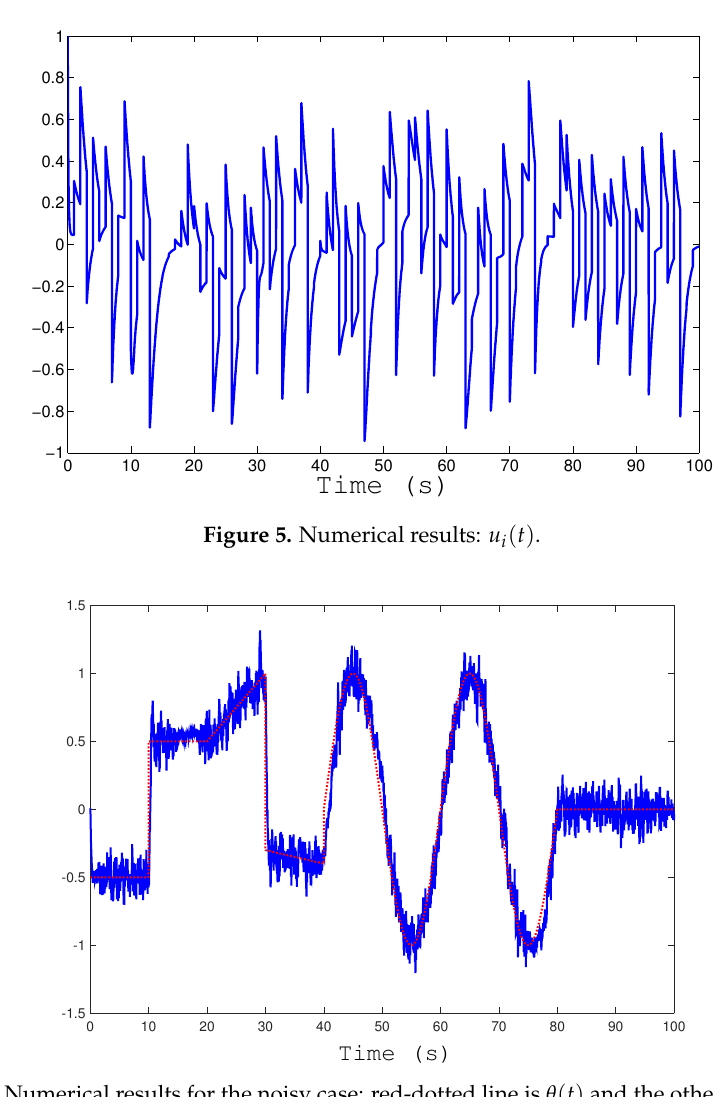
Figure 6. Numerical results for the noisy case: red-dotted line is θ ( t ) and the other one is ˆ θ ( t ) .